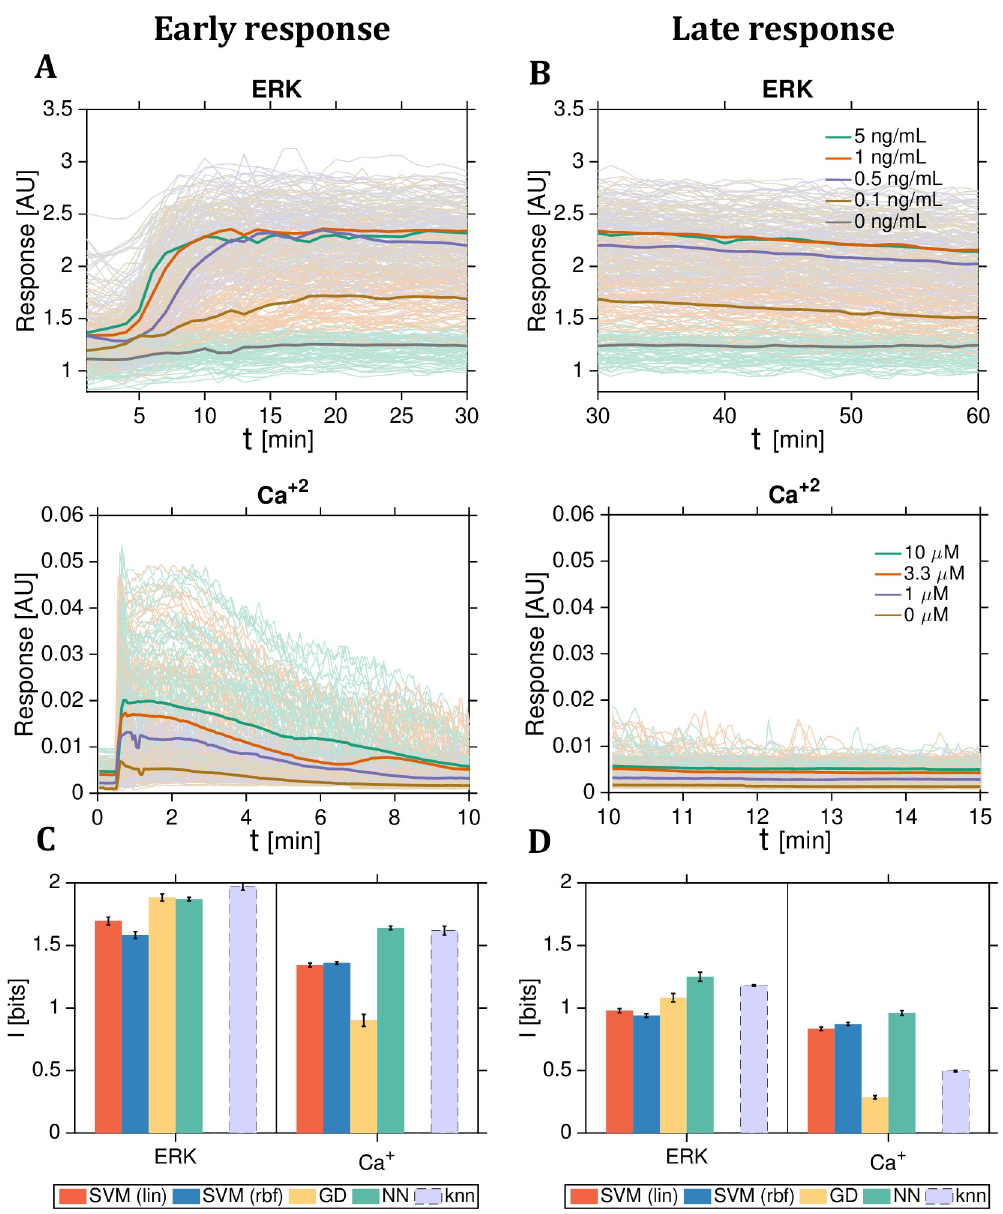
Fig 9. Multilevel mutual information estimates from single-cell time-series data for mammalian intracellular signaling. Data replotted from Ref [26] for ERK (top row) and Ca 2+ (bottom row). (A) Early transient responses after addition of 5 different levels of EGF for ERK (or 4 different levels of ATP for Ca 2+ , respectively) at t = 0 min, as indicated in the legend. (B) In the late response most, but not all, of the transients have decayed. (C,D) Information estimation using different methods (legend) in the early (C) and late (D) period, for ERK (left half of the panels) and Ca 2+ (right half). Data for ERK: N = 1678 per condition, T = 30 min ( d = 30) for early response and T = 30 min ( d = 30) for late response. Data for Ca 2+ : N = 2995 per condition, T = 10 min ( d = 200) for early response and T = 5 min ( d = 100) for late response. Plotting conventions as in Fig 8.